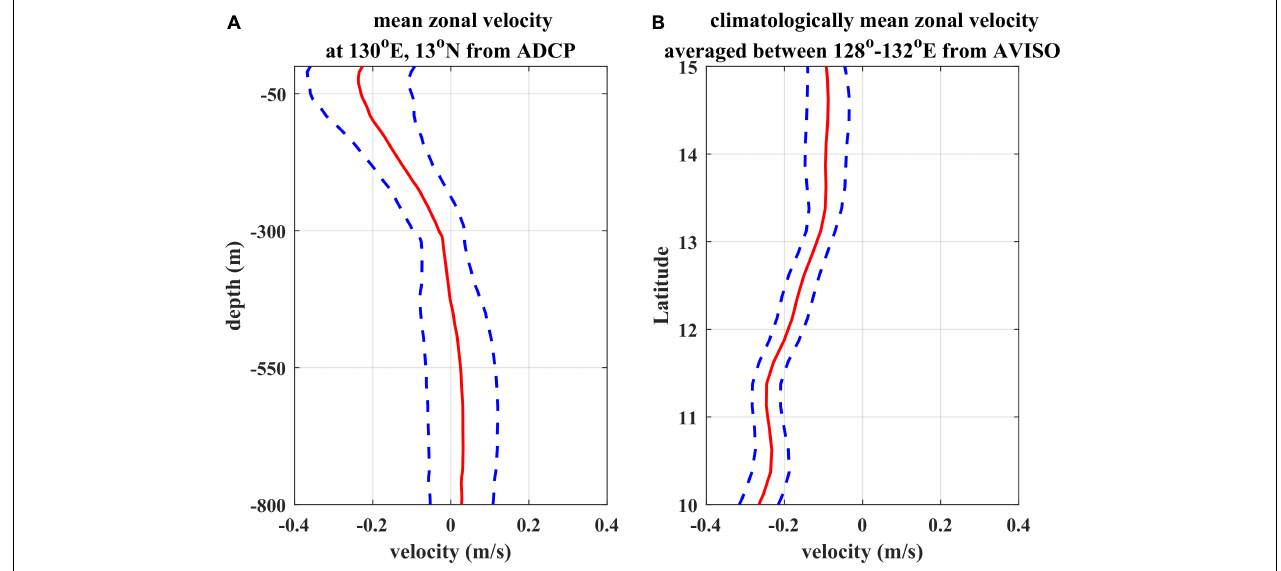
FIGURE 10 | (A) Mean zonal velocity profile (red) above 800 m averaged from the mooring ADCP measurements with the standard deviation (blue), and (B) Mean zonal geostrophic velocity averaged between 128 ◦ and 132 ◦ E from 10 ◦ to 15 ◦ N derived by satellite altimetry with the standard deviation